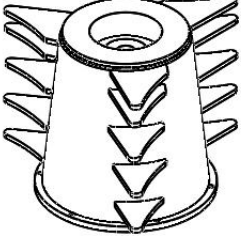
Figure 10. Schematic diagram of vertical drum.